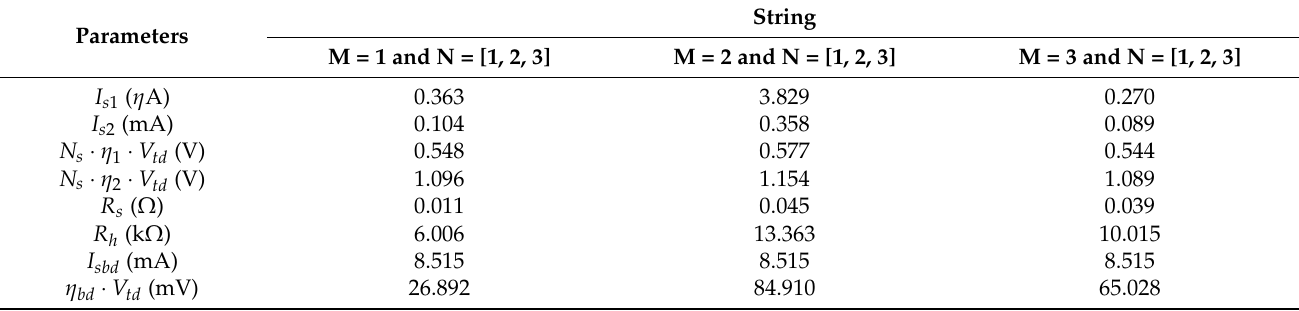
Table 5. Double diode model parameters of the 3 × 3